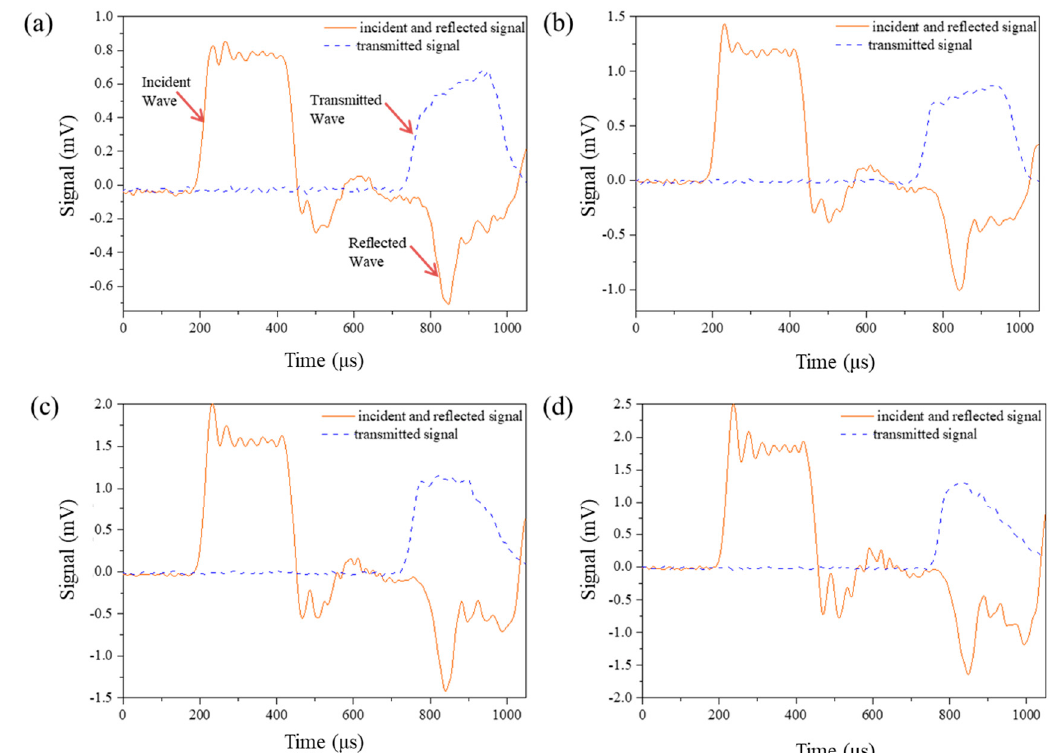
Table 2. Relationship between impact velocity and trigger pressure.